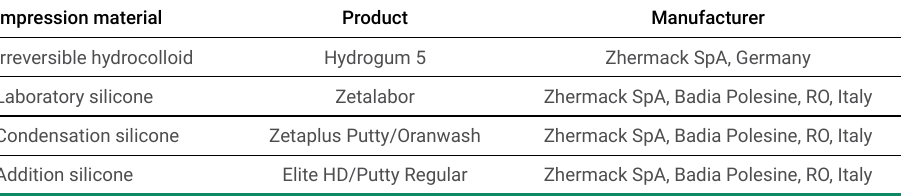
Table 1. Impression materials used in the present study.